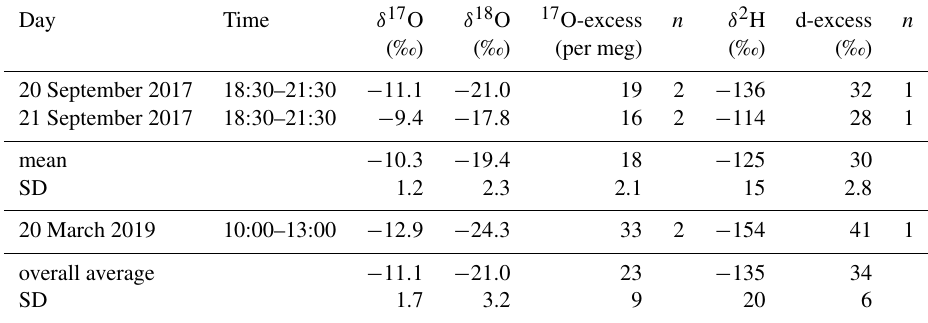
Table 1. Sampling intervals and isotopic data of atmospheric vapour. Day Time δ 17 O δ 18 O 17 O-excess n δ 2 H